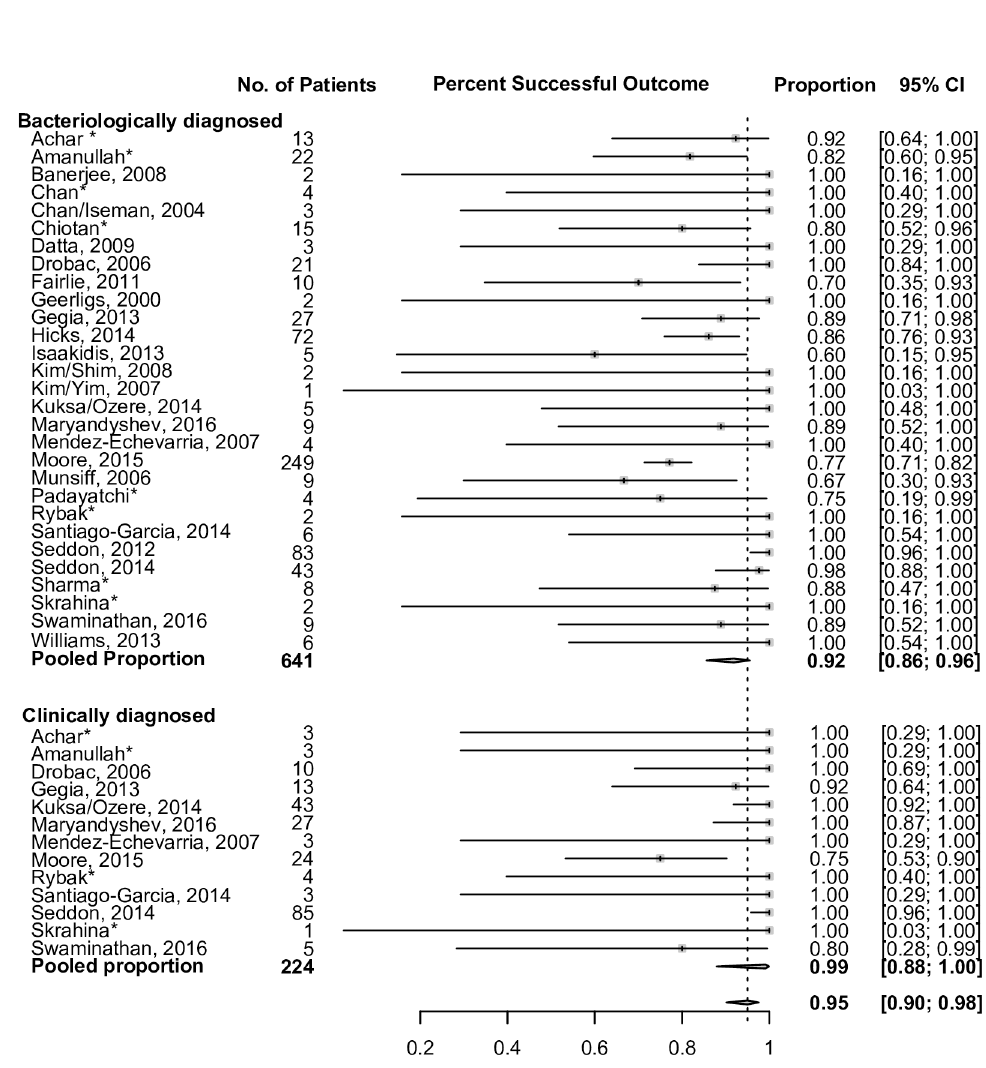
Fig 3. Proportion of patients achieving successful treatment outcomes, stratified by method of diagnosis, by site. Excludes lost to follow-up and cases that did not have an outcome. Results estimated via random effects modeling to account for clustering by cohort. The 95% confidence limits were estimated using exact (Clopper-Pearson) method. (cid:3) Unpublished data.